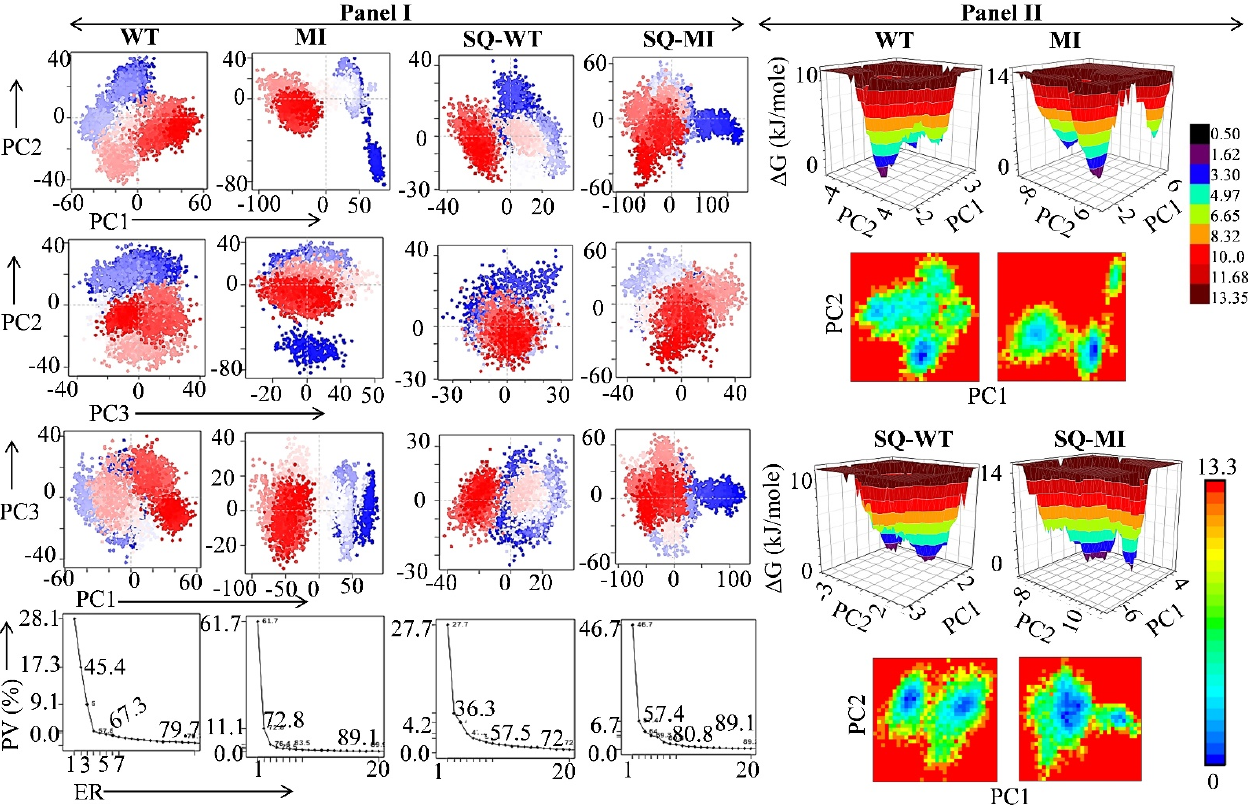
Figure 6. Principal component analysis and free energy landscape of the test systems. ( Panel I ) shows the projection of PC2 vs. PC1, PC2 vs. PC3, PC3 vs. PC1, and the proportion of variance (scree) plot of the WT, SQ-WT, MI, and SQ-MI systems during the simulation period. ( Panel II ) shows the two/three-dimensional free energy landscapes of the WT, SQ-WT, MI, and SQ-MI systems during the simulation period. WT, Wild-type; SQ-WT, Saquinavir-bound wild-type; MI, M46I-mutation-carrying protease; and SQ-MI, Saquinavir-bound mutation-carrying protease; PV, proportion of variance; ER, eigen value